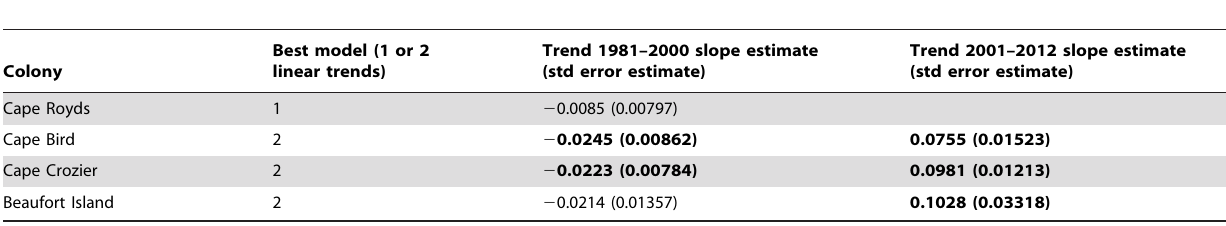
Table 2. Summary of trend models for Cape Royds, Cape Bird and Cape Crozier (Ross Island) and Beaufort Island colony counts (log e -transformed) with predictor units in years from 1981 to